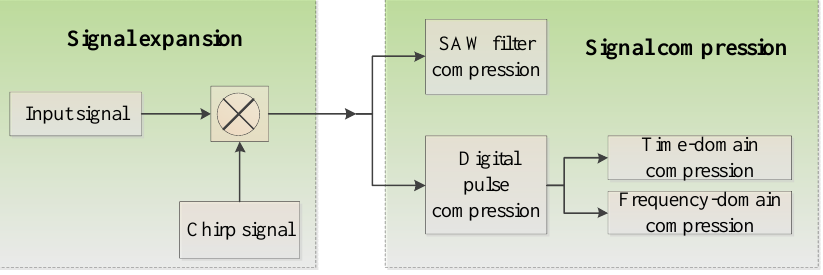
Figure 1. Schematic diagram of pulse compression procedure in radar system. SAW—surface acoustic